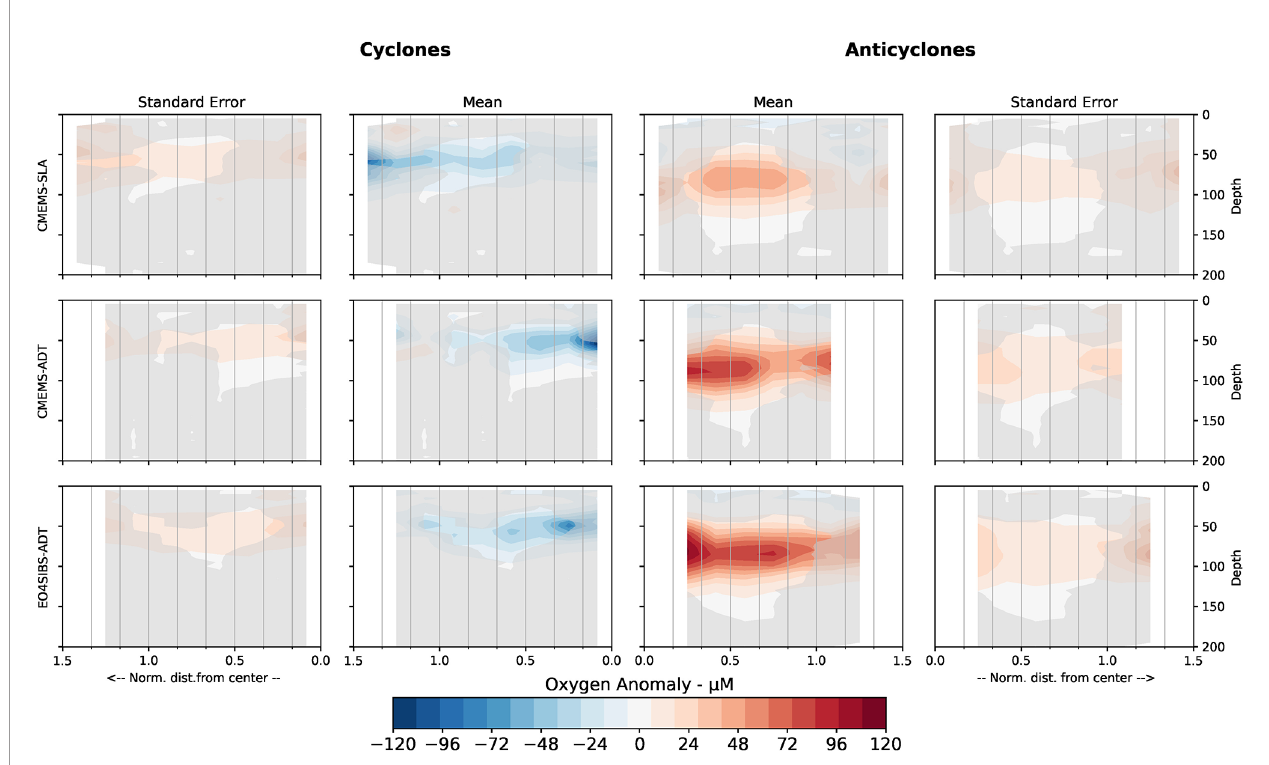
FIGURE 11 | Same as Figure 10 for